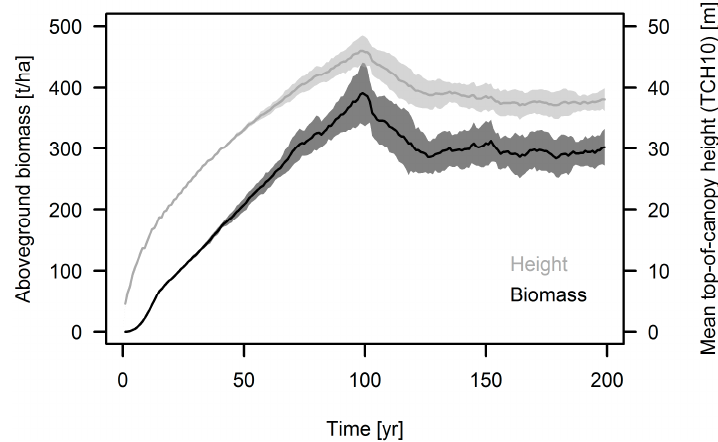
Figure A1. Development of aboveground biomass and mean top-of-canopy height over time during primary succession in a FORMIND run using the Barro Colorado Island (BCI) parameterization. Lines represent the mean of 16 ha and envelopes the standard deviations at 1 ha scale.